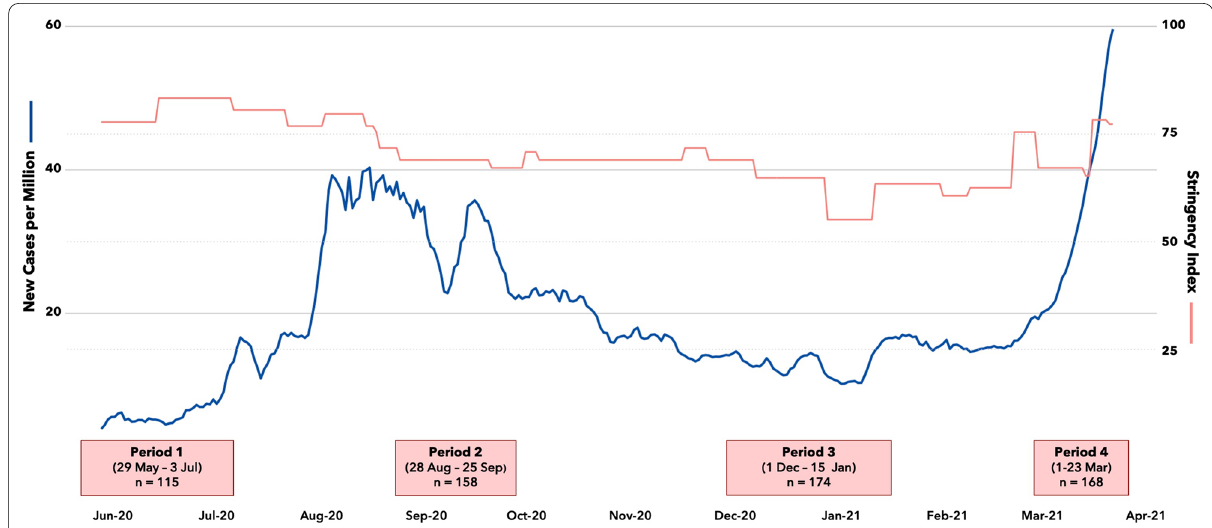
Fig. 1 Data collection flow. Study enrollment took place over four periods, during which time the Philippines underwent varying levels of lockdown. The Oxford COVID-19 Government Response Tracker Stringency Index aggregates and summarizes the closure and containment policy indicators employed at national and subnational levels in response to the pandemic. It takes values between 0 and 100, with the most stringent government response set at